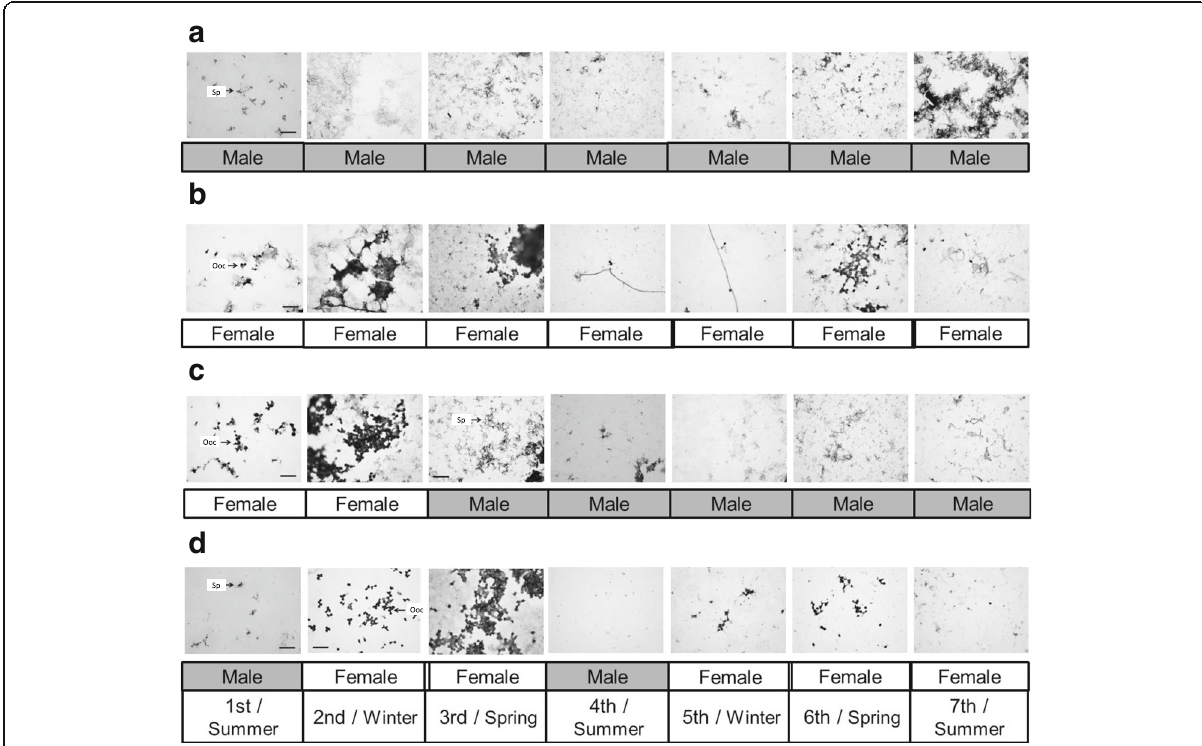
Fig. 3 Four typical sex-changing patterns of Akoya pearl oyster ( P. fucata ) ( a ) all-period male, ( b ) all-period female, ( c ) female changed to male, ( d ) changing between male and female. Sex-changing pattern was based from the sex of Akoya checked by biopsy at seven sampling times. Each symbol indicates: Sp, sperms; Ooc, oocyte. Scale bar, 200 μ